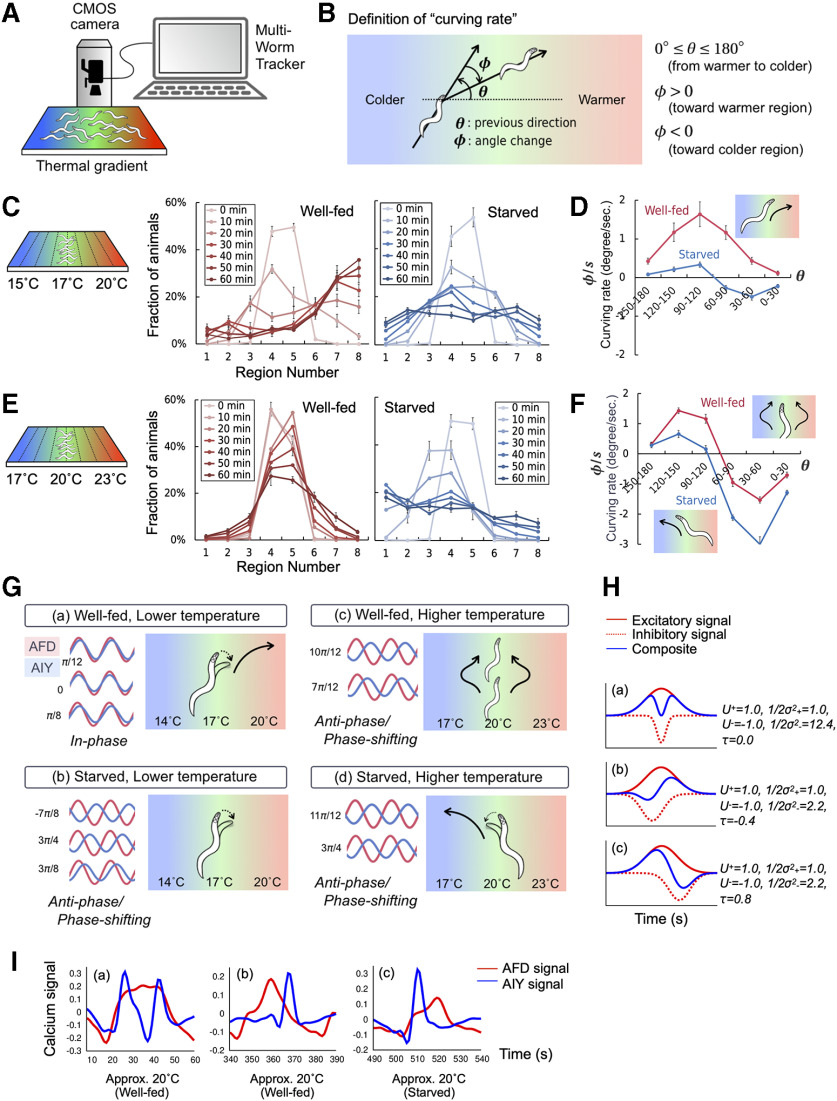
Starvation-induced modulation of curving behavior on a thermal gradient and its correlation with AFD-AIY activities. A, The schematic figures of MWT. B, Definition of curving behavior on a thermal gradient. C, Thermotaxis behavior of 20°C-conditioned animals on 17°C-centered thermal gradient. The left panel with red lines indicates the distribution of well-fed animals in each section of the thermotaxis assay plate (n = 9). The right panel with blue lines is for starved animals (n = 5). The values indicate means ± SEM, and as the color of line changes from light to dark, it indicates that time passed since the starts of assays. D, Curving rate of well-fed and starved animals measured from 10 to 20 min after placing the animals on the assay plate. E, Thermotaxis behavior of 20°C-conditioned animals on 20°C-centered thermal gradient (well-fed n = 6, starved n = 6). F, Curving rate of well-fed and starved animals measured from 0 to 10 min after placing the animals on the assay plate. G, Relationship between temporal AFD-AIY interaction and behavioral outputs on a thermal gradient. The schematic diagram of neuronal activity patterns is displayed next to the diagrams showing the relevant animal locomotion on a thermal gradient. The red and blue traces represent AFD and AIY activities, respectively. The numerical values written next to the diagram of AFD-AIY activities represents the mean direction of phase shit. The three activity patterns observed under the thermal stimulus Osci1721, Osci1523, and Osci17 are shown in order from the top (a, b). The two activity patterns observed under the thermal stimulus Osci1721 and Osci1523 are shown in order from the top (c, d). H, Various patterns of interneuron activities can be generated by composing excitatory and inhibitory signals from sensory neurons. The red and blue lines represent excitatory and inhibitory signals written by Gaussian function, respectively. The numerical values indicate the parameters of Gaussian function. I, Neuronal activity patterns similar to the numerically calculated patterns were observed in the experiments.